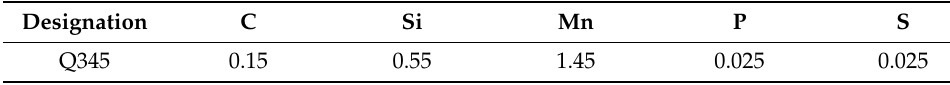
Table 1. Chemical composition of Q345 steel ( ω %).